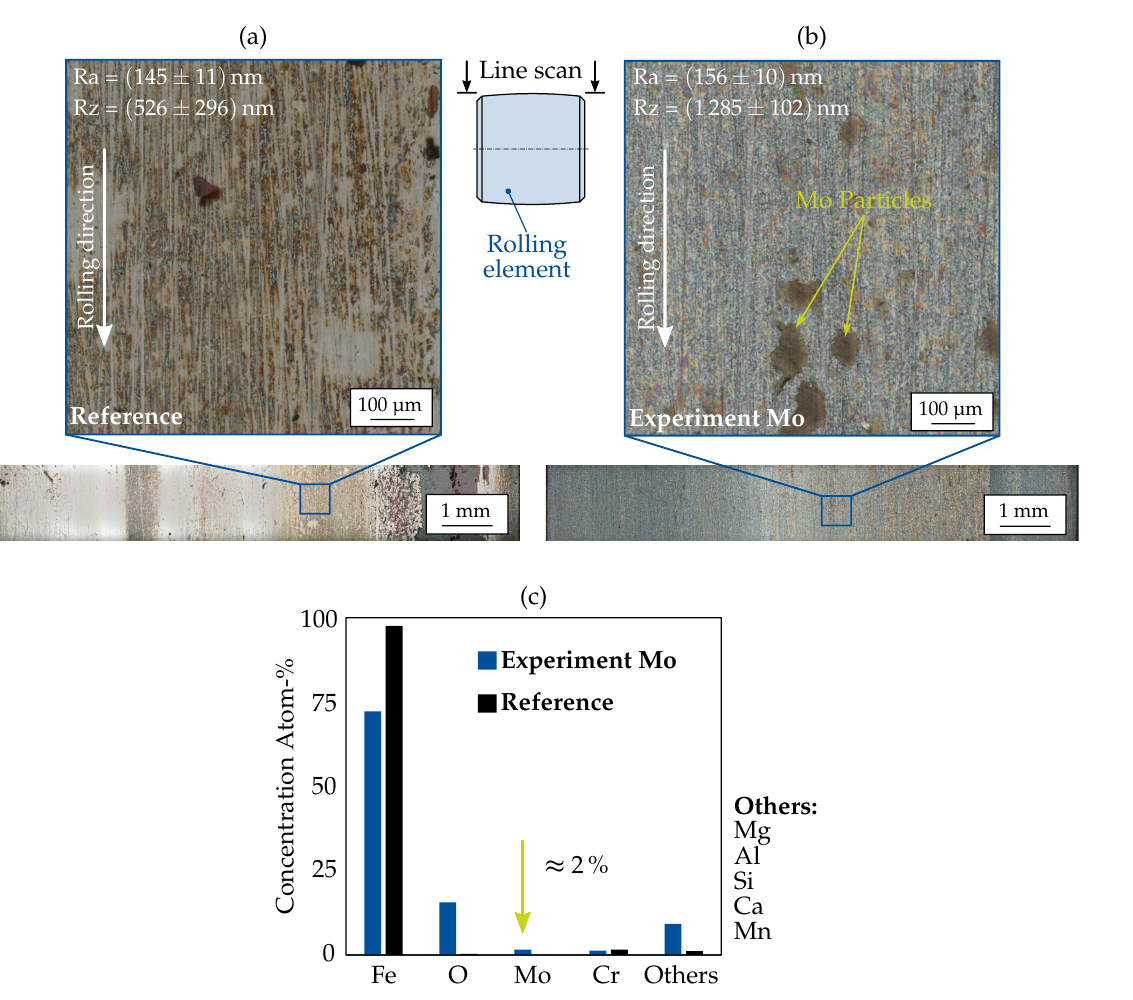
Figure 8. Surface analysis of the rolling elements: ( a ) Representation of the reference experiment. Significant accumulation of oxides due to tribo-oxidation and partial cold welding could be